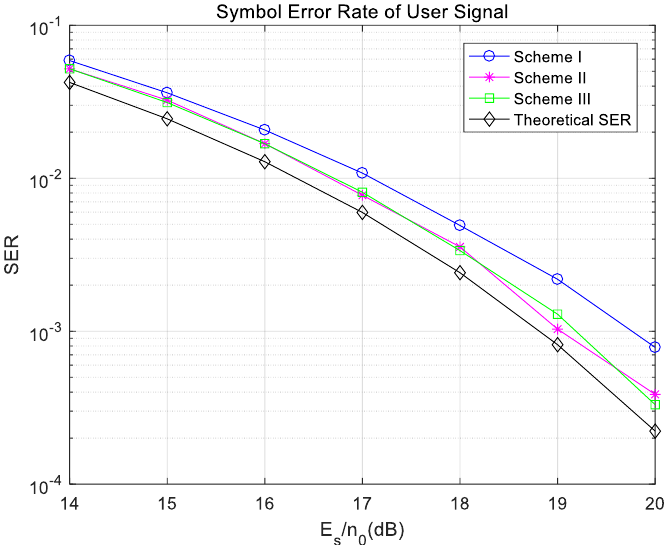
Figure 17. Symbol error rate of the user data under ideal synchronization in the fading channel.